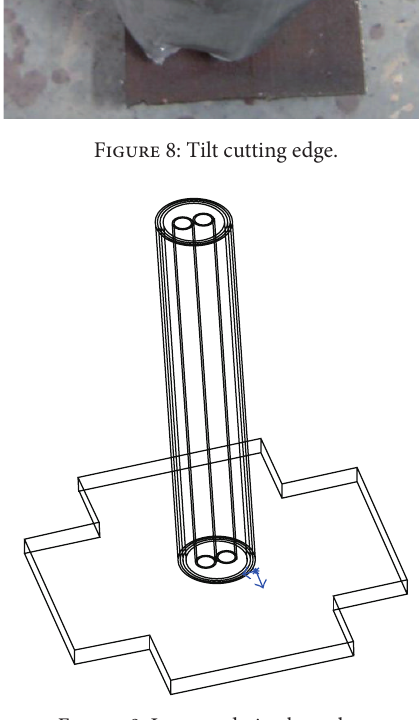
Figure 9: Improved pipe baseplate.